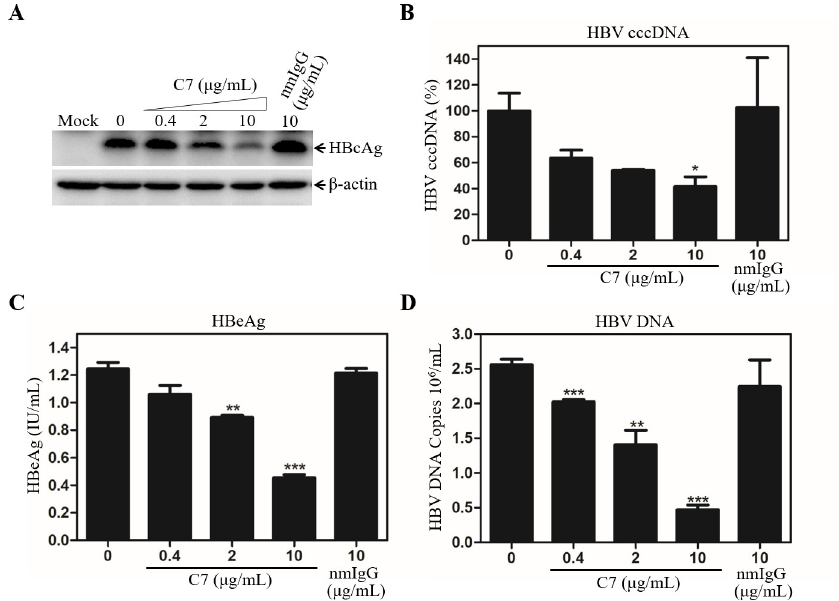
Fig 1. Blockade of HBV infection by a LDLR-specific monoclonal antibody. HepG2 NTCP cells seeded in 24-well plates were infected with HBV in the presence of 4% PEG and increasing concentrations (0, 0.4, 2, and 10 μ g/mL) of the LDLR monoclonal antibody (C7). A normal mouse IgG (nmIgG) was used as a negative control. After 12-h infection at 37˚C, the HBV-infected cells were washed with PBS and incubated with DME/F12 containing 3% FBS, 1% DMSO, 5 μ g/mL hydrocortisone (HC), and corresponding concentrations of C7 or nmIgG for 4 days. Cell lysates were collected for detection of HBV core antigen (HBcAg) by Western blot using β -actin as a house-keeping gene control ( A ). HBV cccDNA in the cells was extracted with the Hirt method and treated with exonucleases I, III, and T5, as previously described [22]. The levels of HBV cccDNA were determined by a Real-Time PCR method ( B ). The levels of HBeAg in the supernatants were quantified by the previously described chemiluminescence immunoassay ( C ). The levels of HBV genomic DNA in the supernatants were also quantified by a Real-Time PCR method ( D ). The average levels of HBV cccDNA, HBeAg, and HBV DNA were obtained from three independent experiments and plotted against C7 concentrations. � P < 0.05, �� P < 0.01, ��� P < 0.001.